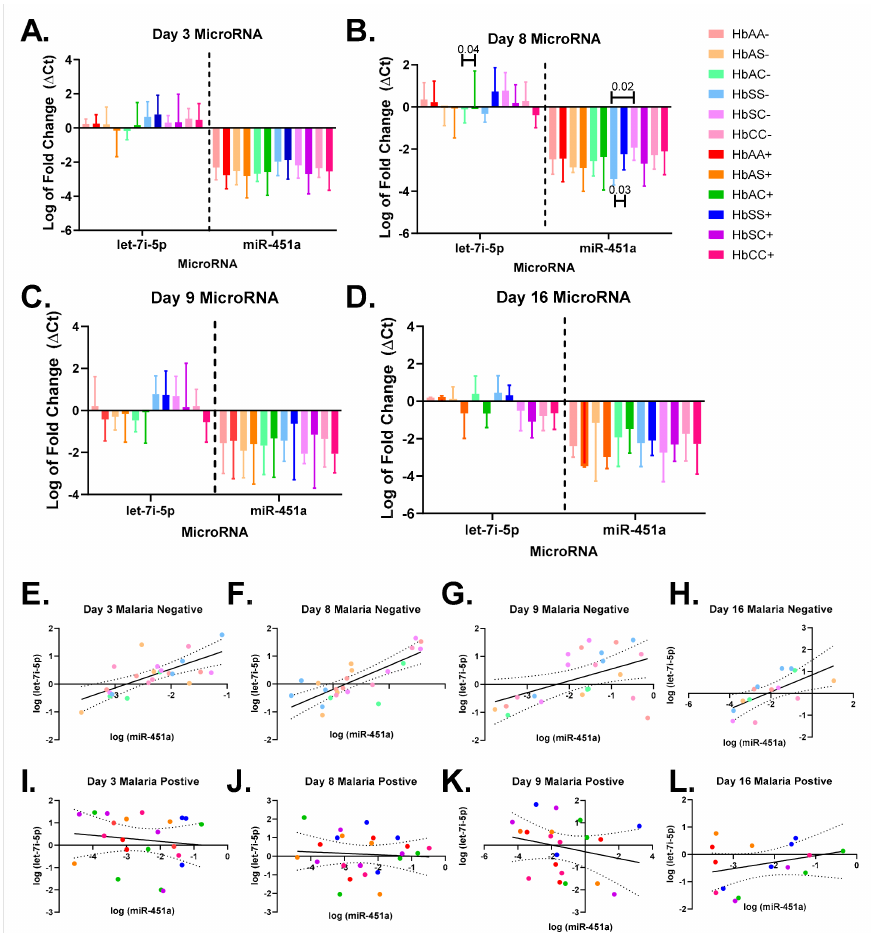
Figure 5. Exosomal miR-451 and let-7i-5p correlation and comparison between sickle Hb geno- types for days 3, 8, 9, and 16. Statistical analyses were performed using ANOVA and Tukey’s multiple comparison or Pearson correlation tests as appropriate, with significance determined for malaria-positive or negative sickle Hb genotypes unless stated otherwise. ( A ) displays miRNA gene expression on day 3, where no significant differences were found between malaria-positive or negative sickle Hb genotypes. In ( B ), miR-451a expression was significantly lower in HbSS- compared to HbSC- on day 8 ( p = 0.02), while miR-451a was significantly higher in HbSS+ compared to HbSS ( p = 0.03) and let-7i-5p was significantly higher in HbAC+ compared to HbAC- ( p = 0.04) using an unpaired t -test. ( C , D ) demonstrate no significant differences in miRNA expression levels on days 9 and 16, respectively, for malaria-positive or negative sickle Hb genotypes. In ( E – H ), there were significant correlations found between exosomal miR-451a and let-7i-5p levels for malaria-negative sickle Hb genotypes on days 3, 8, 9, and 16, with respective equations of Y = 0.6803*X + 1.901, Y = 0.8521*X + 2.365, Y = 0.4235*X + 0.9760, and Y = 0.3904*X + 0.8477. The correlations had R 2 values of 0.48, 0.61, 0.24, and 0.45 and were all significant with p -values of 0.0003, <0.0001, 0.02, and 0.009, respectively. ( I – L ) display no significant correlations between exosomal miR-451a and let-7i-5p levels for malaria-positive sickle Hb genotypes on days 3, 8, 9, or 16, respectively, with respective equations of Y = − 0.1365*X – 0.1045, Y = − 0.07589*X – 0.07005, Y = − 0.1509*X – 0.2939, and Y = 0.2378*X + 0.1944. The p -values for all correlations were greater than 0.05. Additionally, the figures show the log-fold change in miRNA expression levels for days 3, 8, 9, and